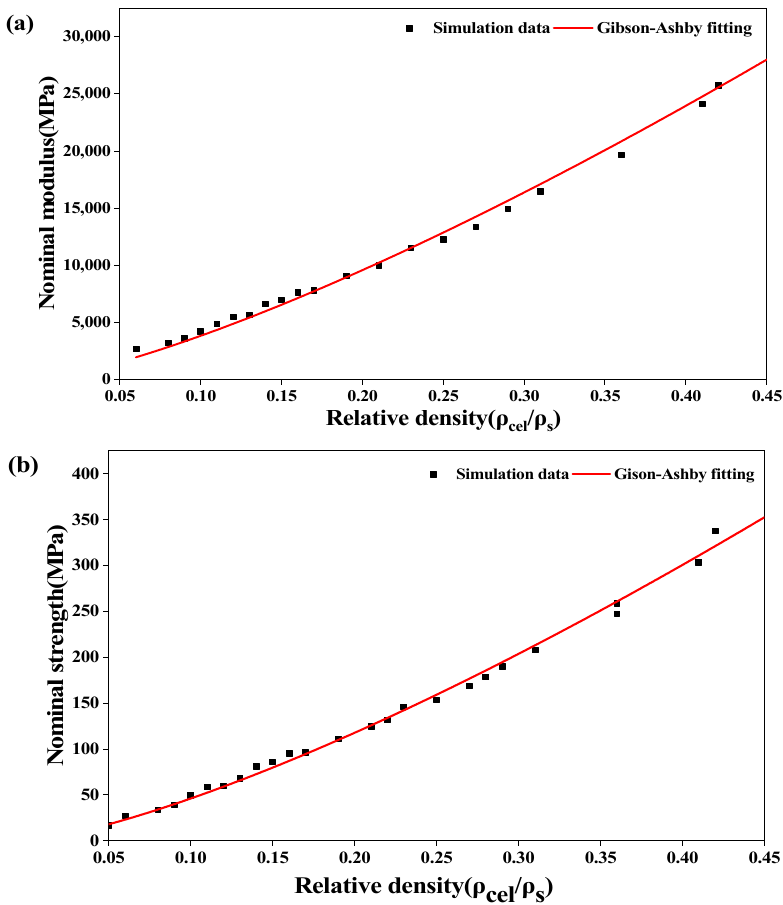
Figure 8. Variations in ( a ) nominal modulus and ( b ) nominal maximum strength of the D structure with relative density.